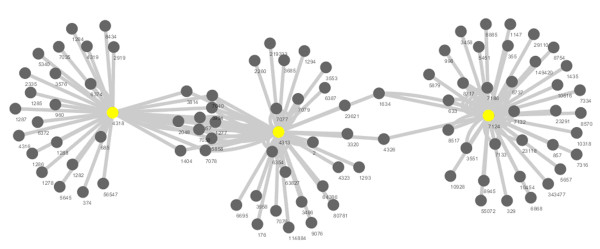
Solid map on huge interactome of rhein-targets networks, built and visualized with Cytoscape. Edges: interactions. Nodes: specific proteins or genes. Central nodes (Yellow) of the interaction network were used to illustrate the gene expression obtained and represents significant change in expression. The connections between molecules show molecular interactions identified in the interactome. Gene expression illustrated in colored nodes was selected with a p < 0.05 value.